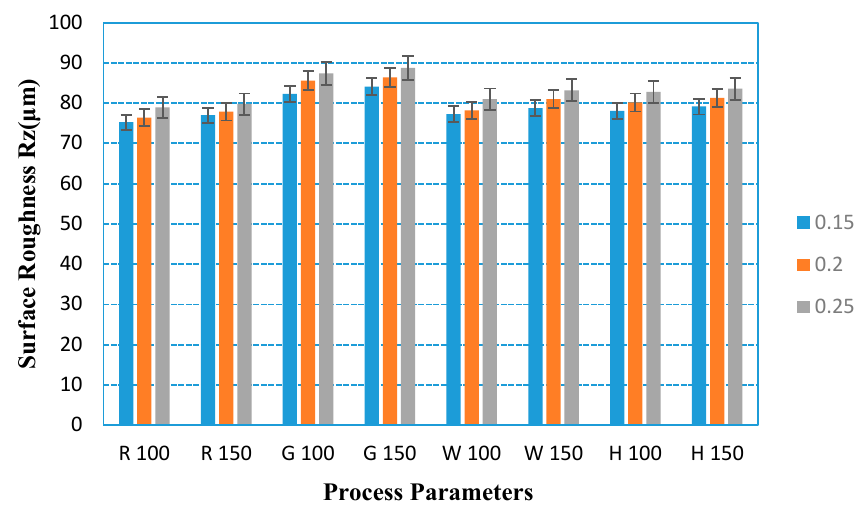
Figure 10. Surface roughness of ABS tested parts under di ff erent process parameters.